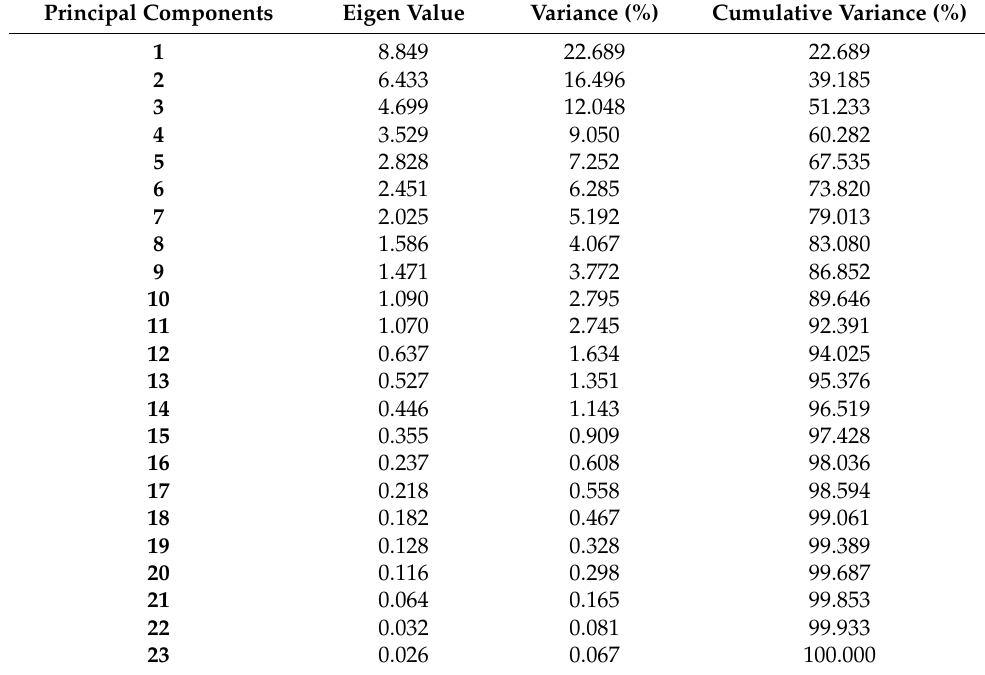
Figure 6. Landrace by trait (L*T) biplot for agro-morphological and biochemical traits. Phenotypic diversity for different morphological traits was calculated based on total of 34 agro-morphological traits including pre-harvest plant traits and post-harvest ear and kernel traits and 5 biochemical traits. Some traits shown in this figure have been abbreviated and full forms for the abbreviated traits are presented in Table 5. Landraces from Navajo Blue, LL High, Santa Ana Blue, Flor del Rio, Yoeme Blue, Ohio Blue, Hopi Blue, and Taos Blue are shown in “chartreuse2”, “slateblue4”, “black”, “red1”, “darkorchid2”, “darkorange”, “yellow” and “blue3”, respectively. Traits contributing to PC1 and PC2 are also assigned different colors with a gradient ranging from 1,3, and 5 with “gray15”, “forestgreen”, and “firebrick”, respectively. Larger consensus points for each accession discerns the midpoint of a given accession. Table 5. Eigenvalue, variancecontribution(%),